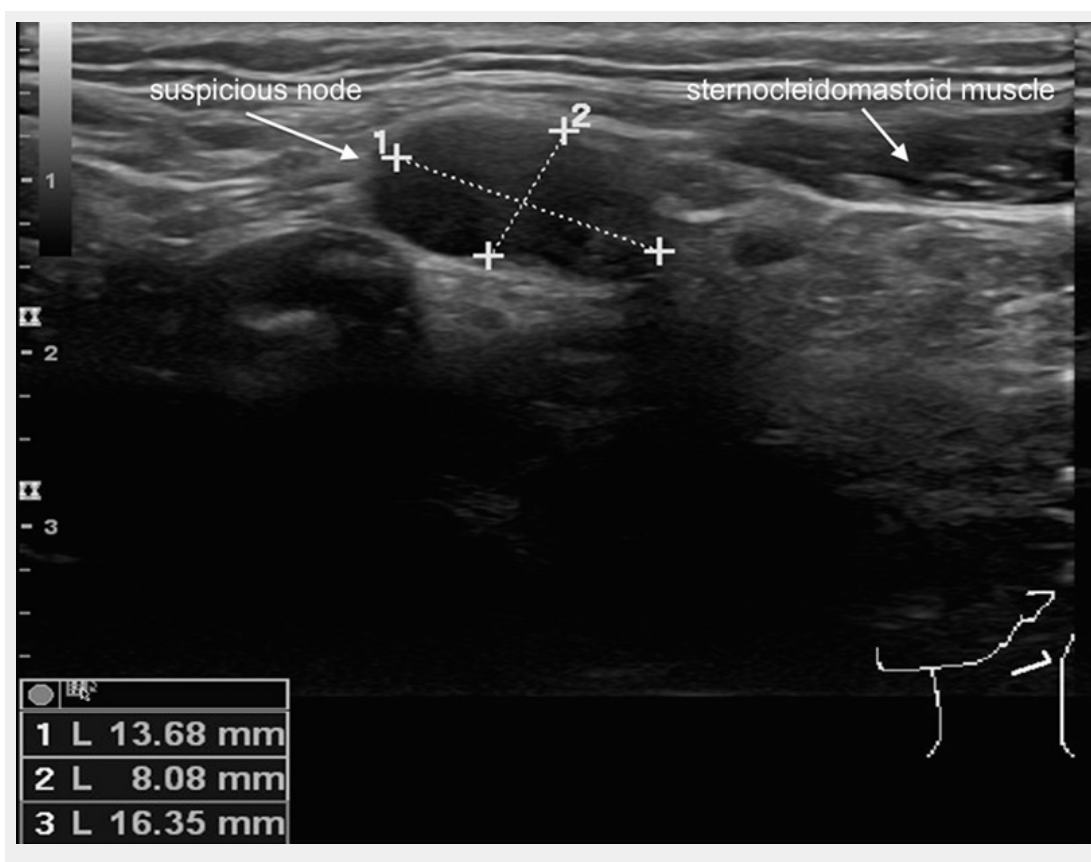
Figure 1 Sonographic appearance of a suspicious lymph node on palpation in level II left from a patient with a small squamous cell carcinoma of the right lateral tongue. The absence of an echogenic hilus, the size of more than 1.5cm and the shape of the lymph node renders it sonographically suspicious. The cytology result after ultrasound-guided fine needle aspiration confirms the presence of a contralateral positive